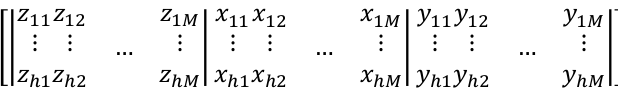
Fig. 2. General view of the chromosome structure